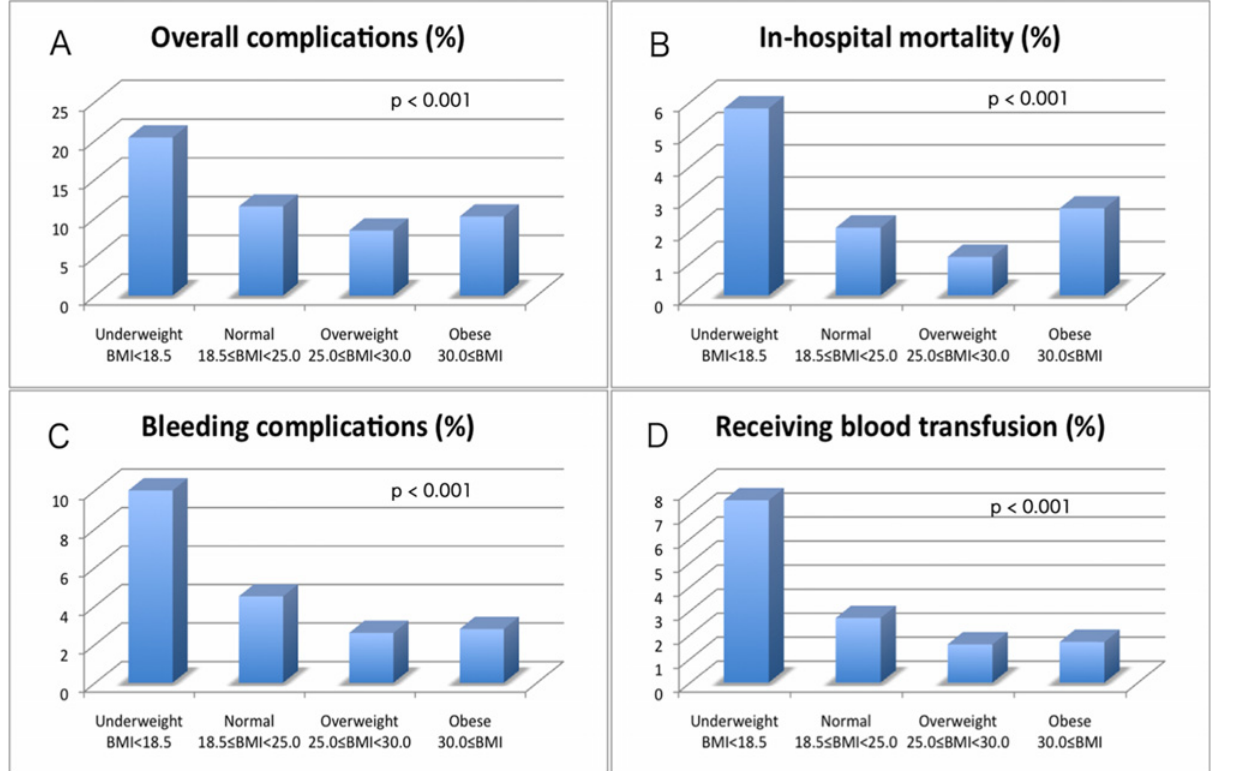
Fig 2. Relationship between BMI and in-hospital complications. In-hospital complication rates by BMI groups in 10,142 patients are shown. A: Overall complications; B: in-hospital mortality; C: bleeding complications within 72 hours; and D: rates of receiving blood transfusion.